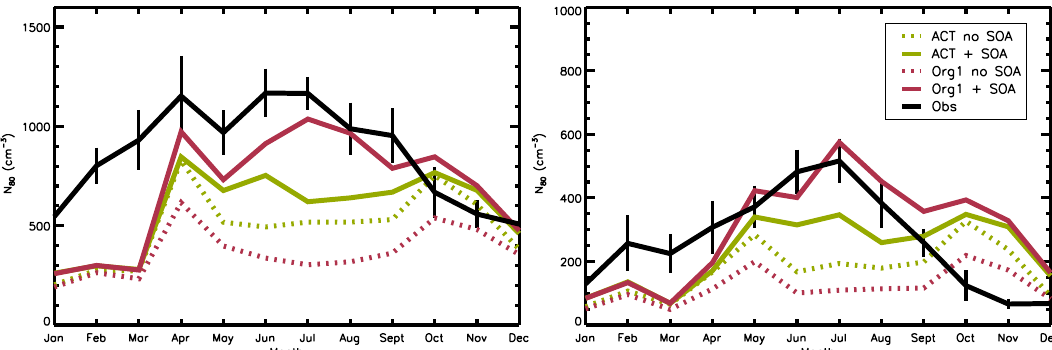
Fig. 4. Multi-annual monthly mean observed (black lines) seasonal cycle in N 80 concentration at Hyytiälä (left) and Pallas (right); standard deviation of the observed monthly mean is indicated by the vertical black lines. N 80 concentrations simulated using the ACT (green; expt. 1 and expt. 4) and Org1 (red; expt. 15 and expt. 16) nucleation mechanisms are shown with biogenic SOA (full lines) and without (dotted lines).